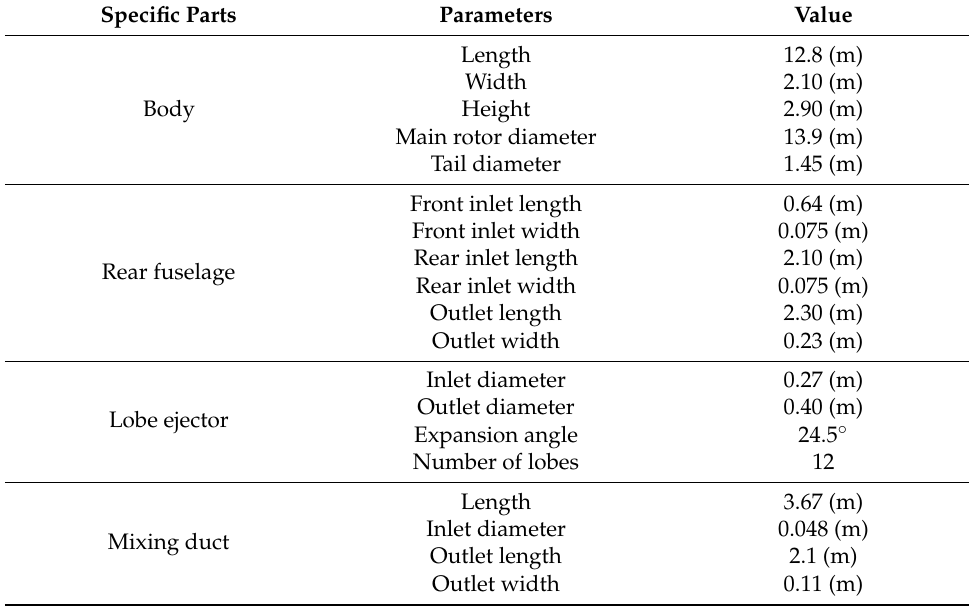
Figure 1. Helicopter model with the integrated infrared suppressor. Table 1. Main geometrical parameters of the helicopter.